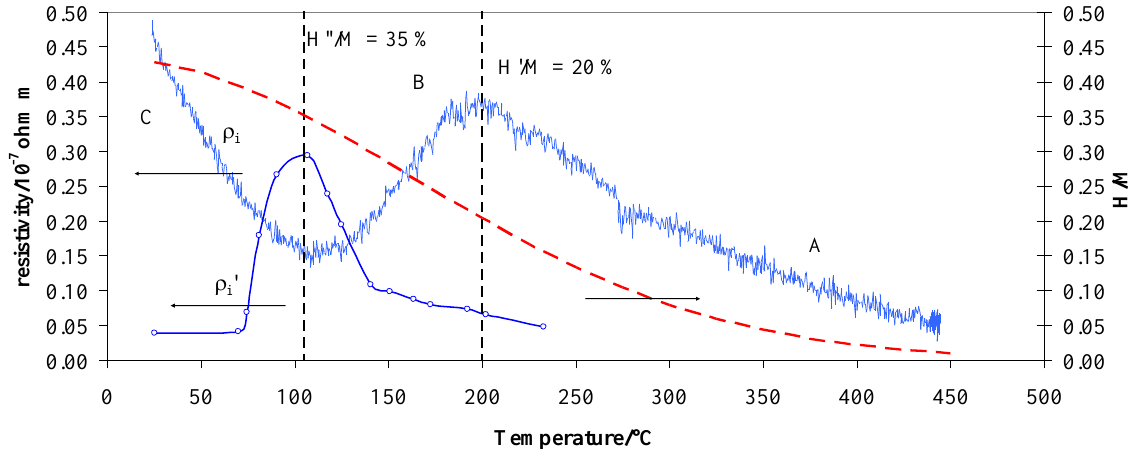
Figure 8. The resistivity contribution due to the scattering of ρ i measured in pure hydrogen and in a vacuum ( ρ i ’) with the H / M vs. temperature in pure hydrogen at 100 kPa.